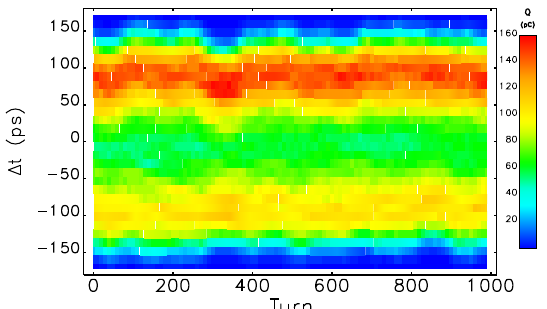
FIG. 14. Charge distribution over 1000 turns from 30-slice analysis for ordinary bunch 22 of a fill with twelve 2-bunch gaps.